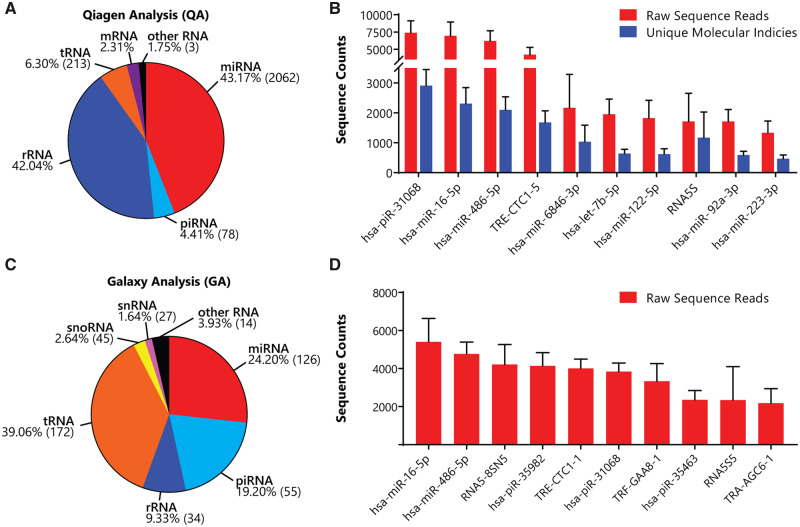

Serum ncRNA reads for small RNA-seq. (A) Proportion of total aligned reads annotated to ncRNA species across all sample pools for the Qiagen-based analysis (QA). Other ncRNA species includes hairpin RNA, snRNA, snoRNA and Y RNA. Number of distinct transcripts are in brackets, except for rRNA and mRNA, which QA does not provide. (B) Top ten read targets present on average across all samples, shown as raw sequencing reads, and after unique molecular indexes have been taken into account for QA. (C) Proportion of total aligned reads annotated to ncRNA species across all sample pools for the Galaxy-based analysis (GA). Other ncRNA species includes scRNA, sRNA, mt_rRNA, mt_tRNA, scaRNA and vaultRNA. Number of distinct transcripts are in brackets. (D) Top ten read targets present on average across all samples in GA, shown as raw sequencing reads. Bars: average ± SEM.